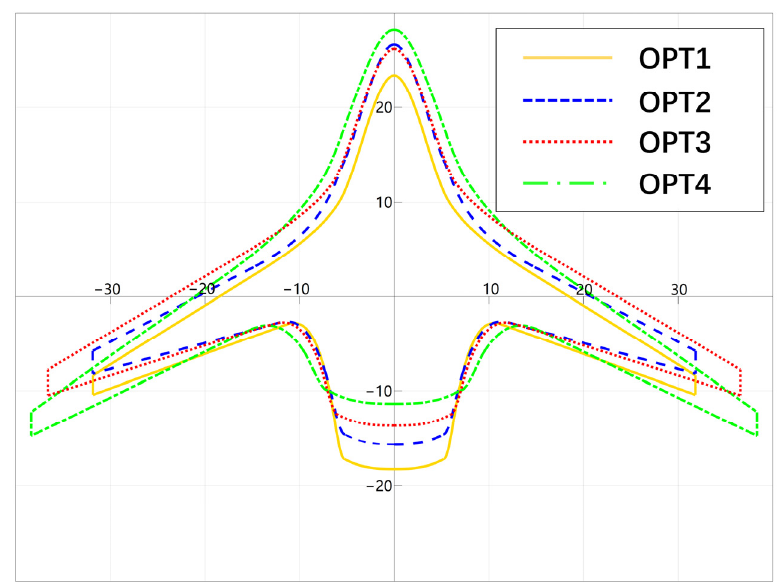
Figure 9. The pareto frontiers of the four optimization results.